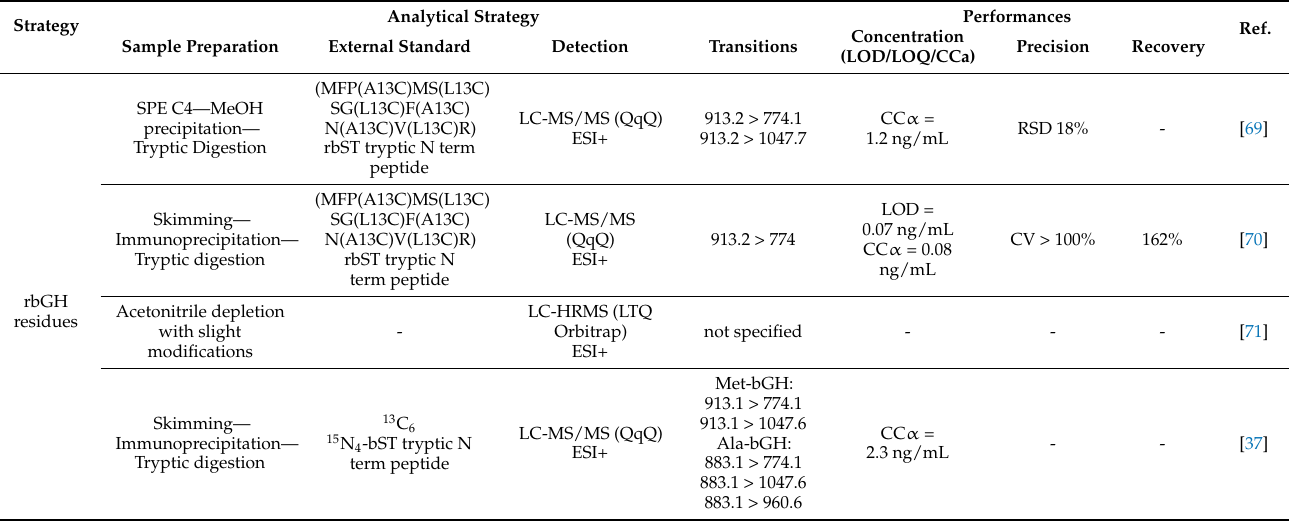
Table 4. Analytical strategies to monitor rbGH residues in